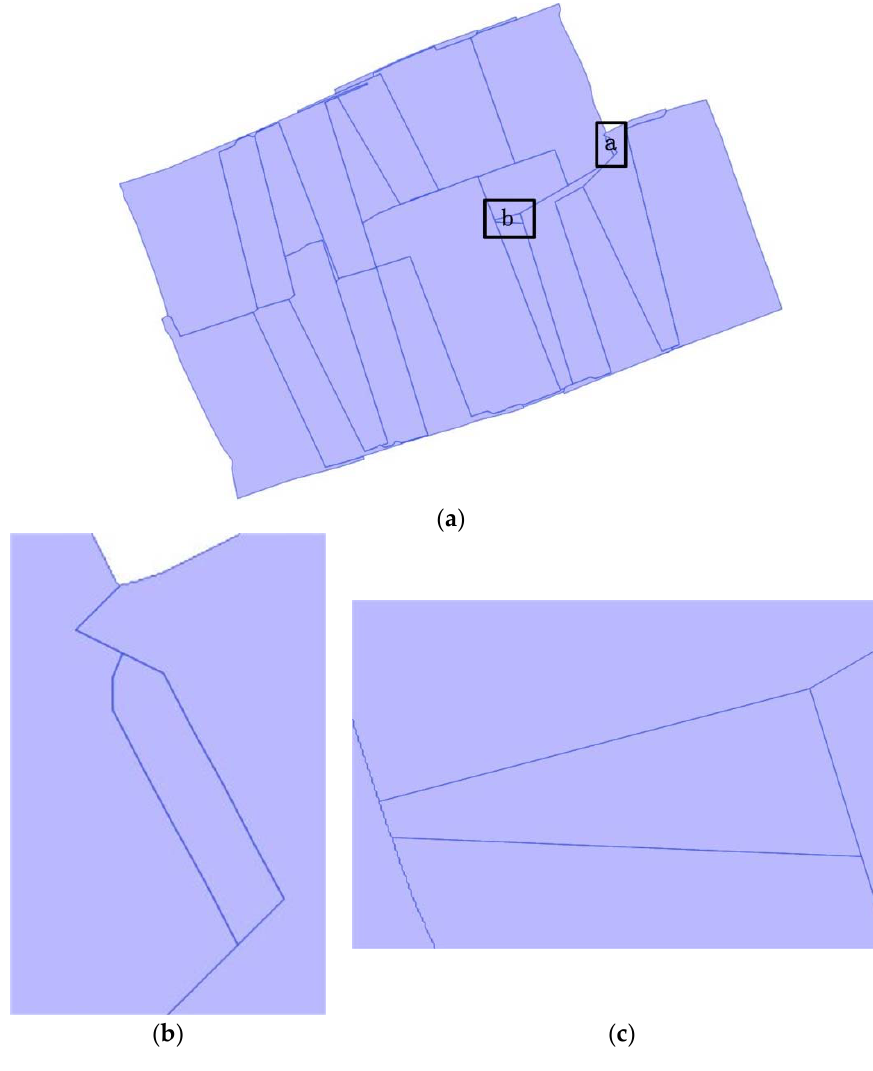
Figure 14. ( a ) The generated seamline network by the method in ERDAS IMAGE 2018; ( b ) the black rectangular area a marked in Figure 14a; ( c ) the black rectangular area b marked in Figure 14a.